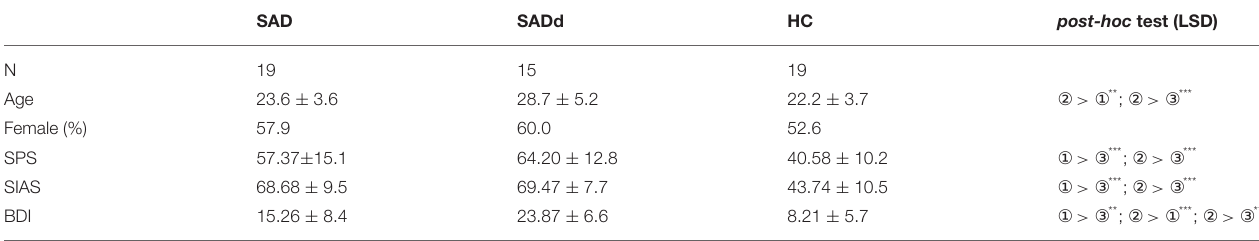
TABLE 1 | Demographic